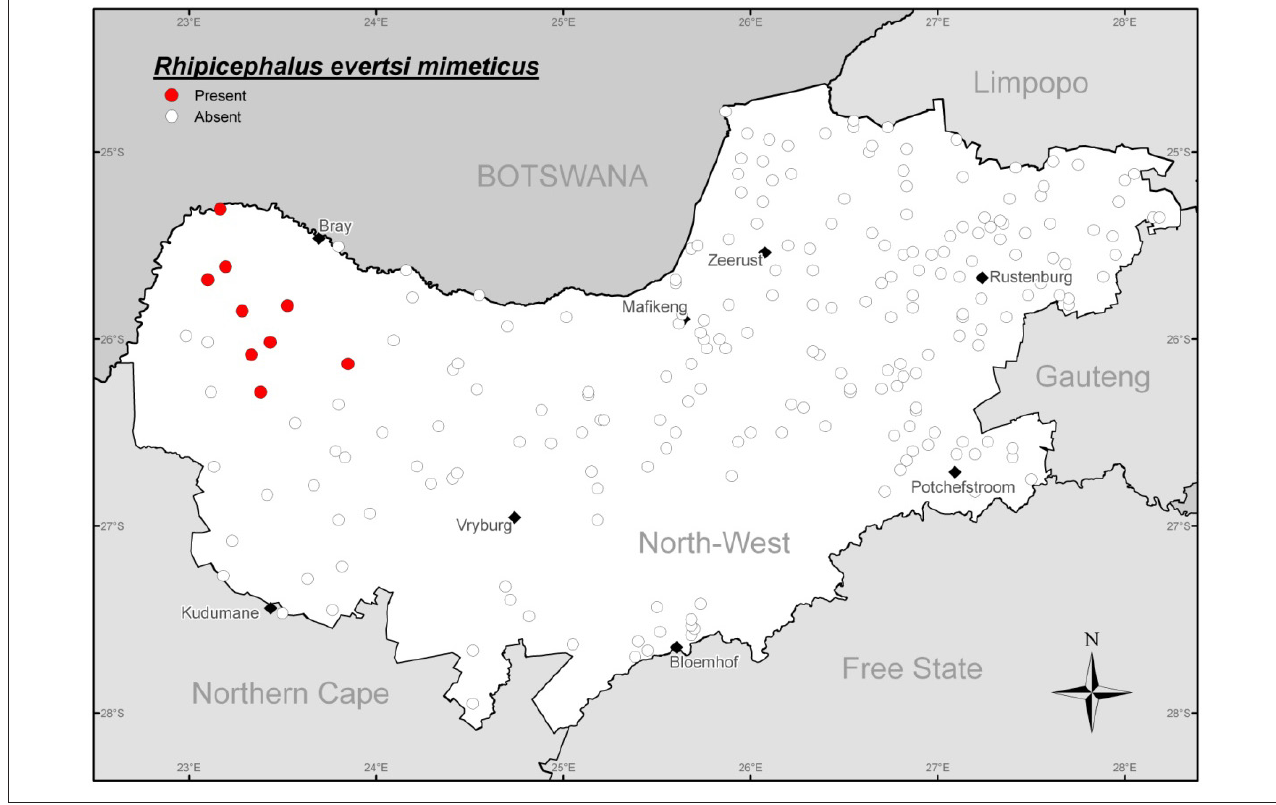
FIGURE 10: The geographic distribution of Rhipicephalus eversti mimeticus in the North West province, South